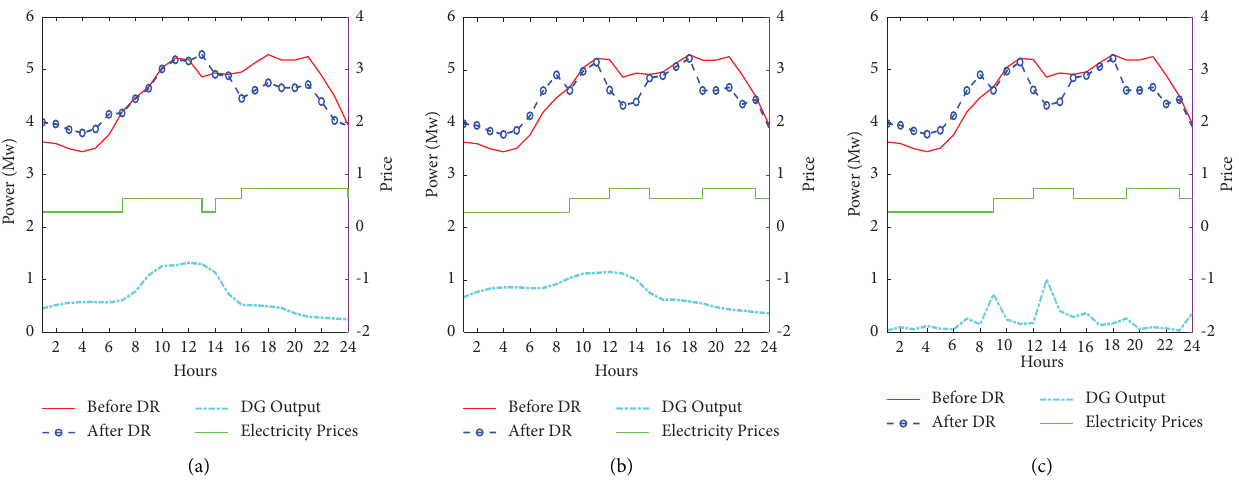
Figure 9: Load and electricity price changes of the three schemes in the scenario with better DG output. (a) Scheme 1. (b) Scheme 2. (c) Scheme